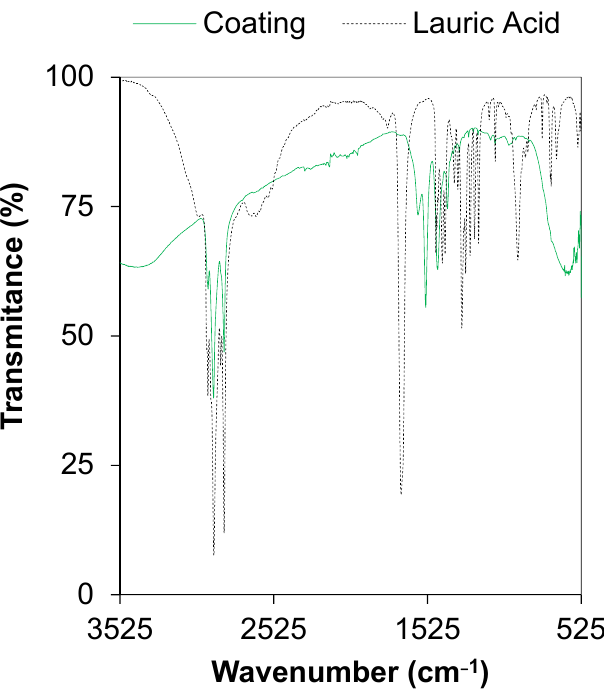
Figure 3. ATR-FTIR spectra of pure lauric acid (dotted line) and the coating (solid line) revealing the presence of a carboxylate functional group assigned to zinc laurate.